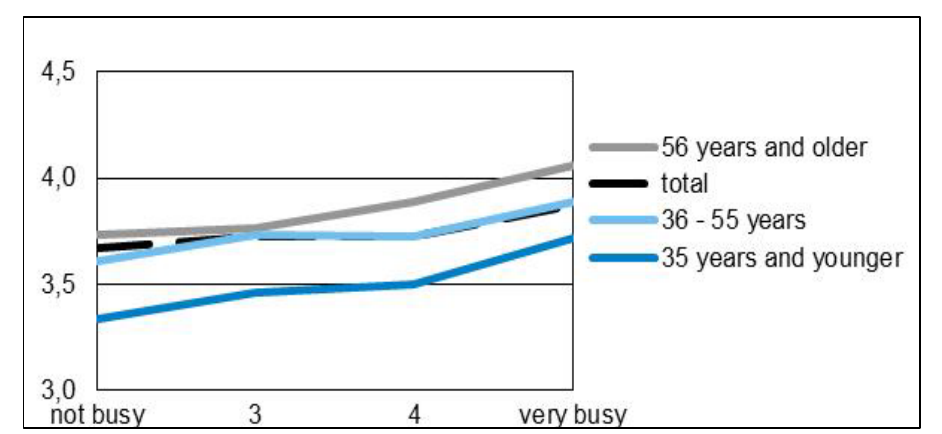
Figure 3. Need for quiet per age group in relation to level of having a busy